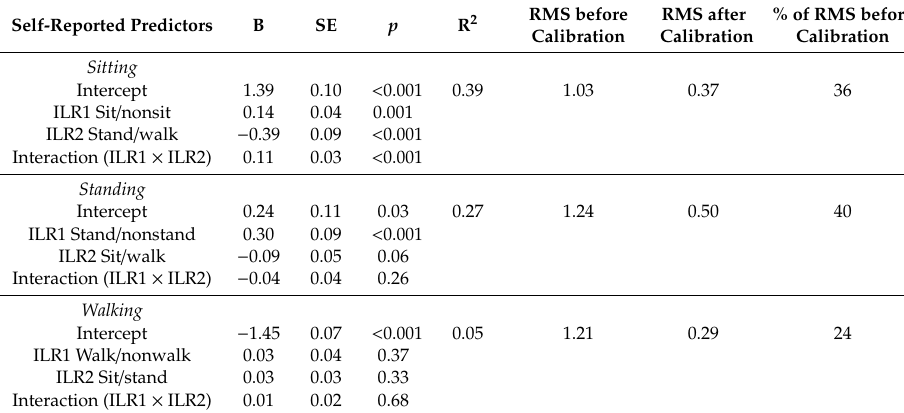
Table 3. Calibration models predicting ‘true’ time use in physical behaviors at work from the compositions of self-reported behaviors. Models are based on compositional data expressed in isometric log-ratios